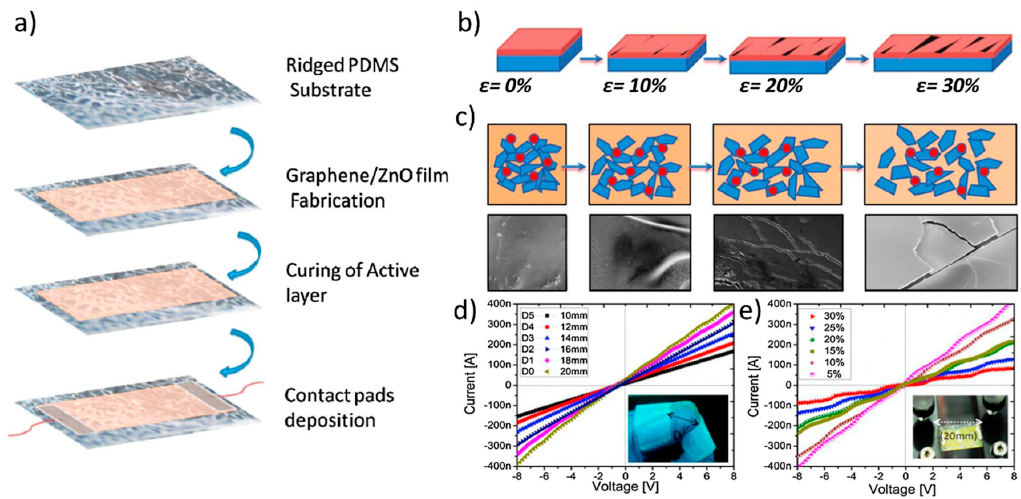
Figure 14. Applications in strain sensors(a) Schematic representation of the fabrication steps for the ZnO / PDMS strain sensor. ( b ) Schematic explanation of the phenomenon that shows the tracks to remain conductive for large deformations under 0%, 10%, 20%, and 30% stretching. ( c ) Schematic explanations of the active layer over substrate with roughness of r = 0.34. On stretching, the gap changing between graphene flakes are increased, and then the electrical resistance of composite film is also increased. ( d ) Current-Voltage curves under bending with di ff erent diameters of strain sensor. ( e ) I-V curves under di ff erent stretching. Reprinted from Ref. [119] Copyright (2018), with permission from Elsevier.